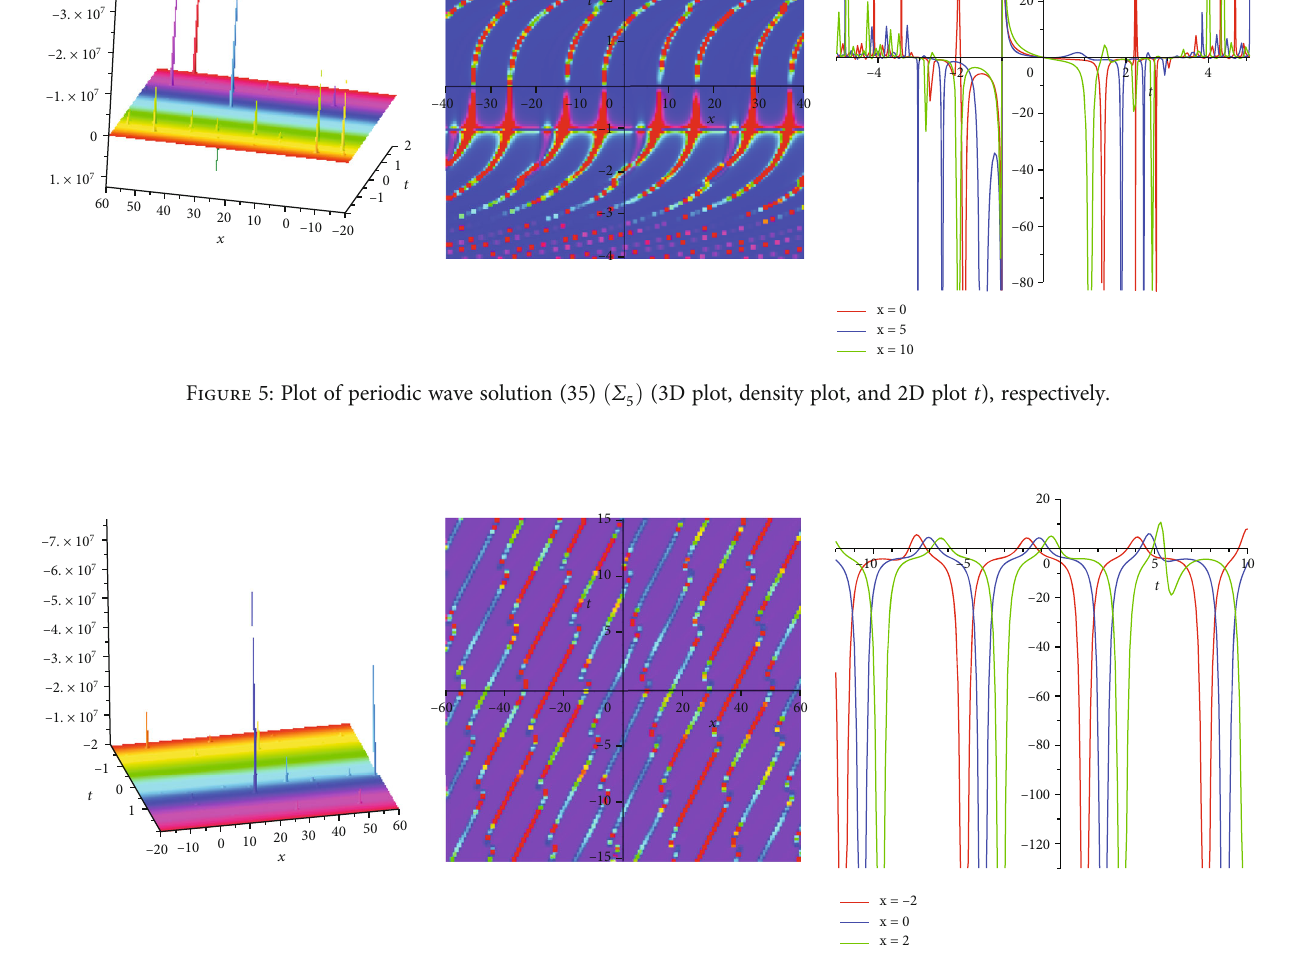
Figure 6: Plot of periodic wave solution (35) ð Σ